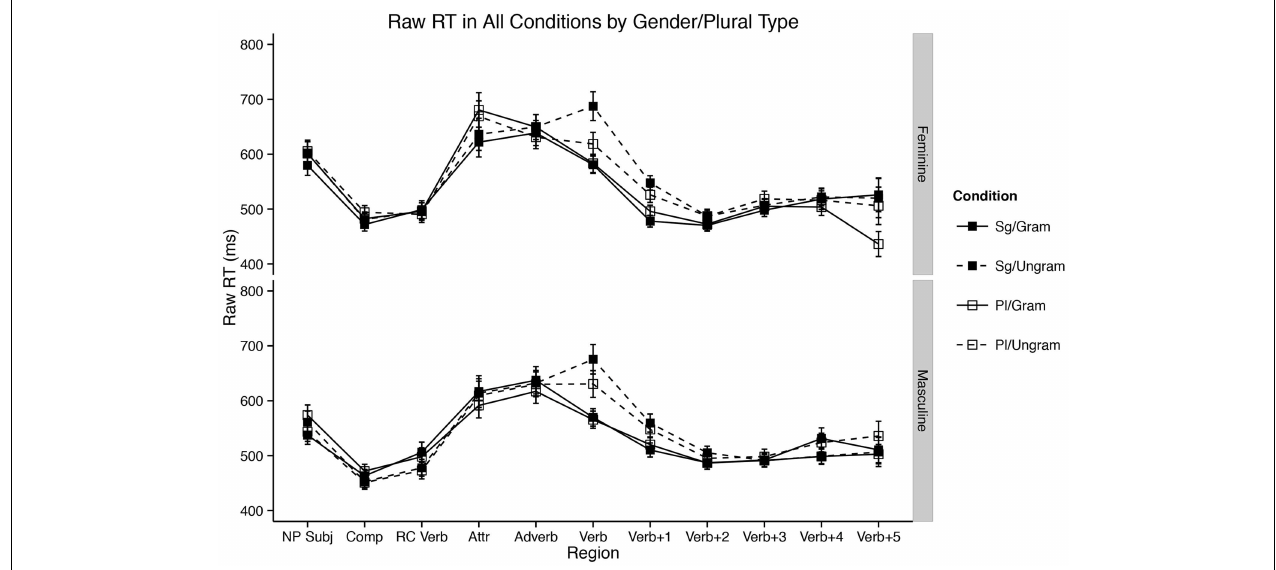
FIGURE 2 | Self-paced reading results. Region by region means segregated by attractor number and verb number for both genders/plural types. Error bars represent the standard error of the mean computed across subject averages.